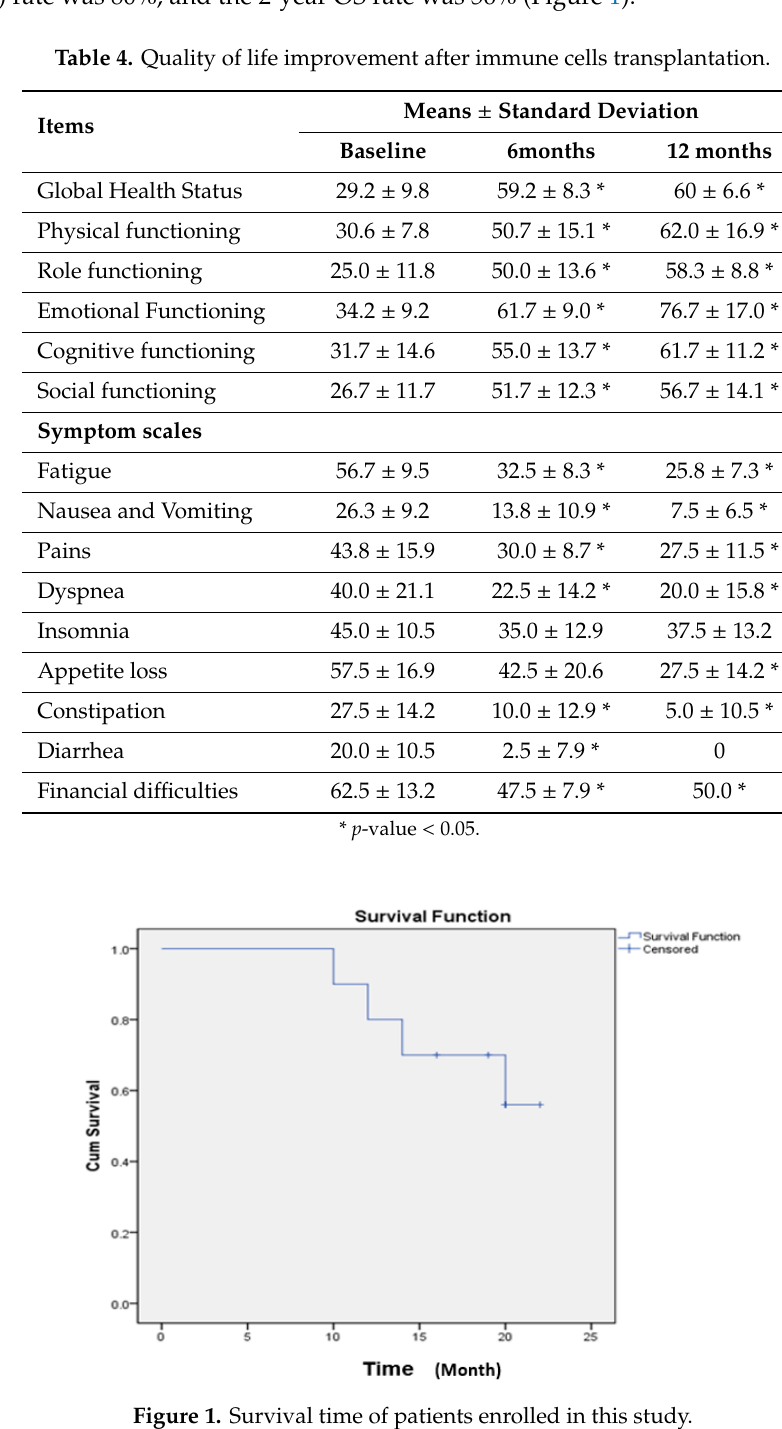
Figure 1. Survival time of patients enrolled in this study.